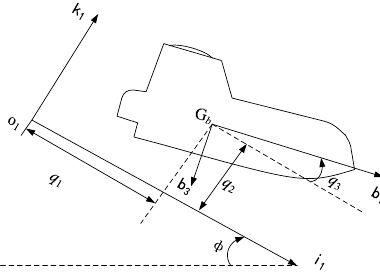
Figure 2. Generalized coordinates 𝑞 𝑟 of the boat in the coordinate system fixed on the skid and the coordinate system attached to the boat with the unit vectors 𝑏 𝑟 (𝑟 = 1,2,3) .